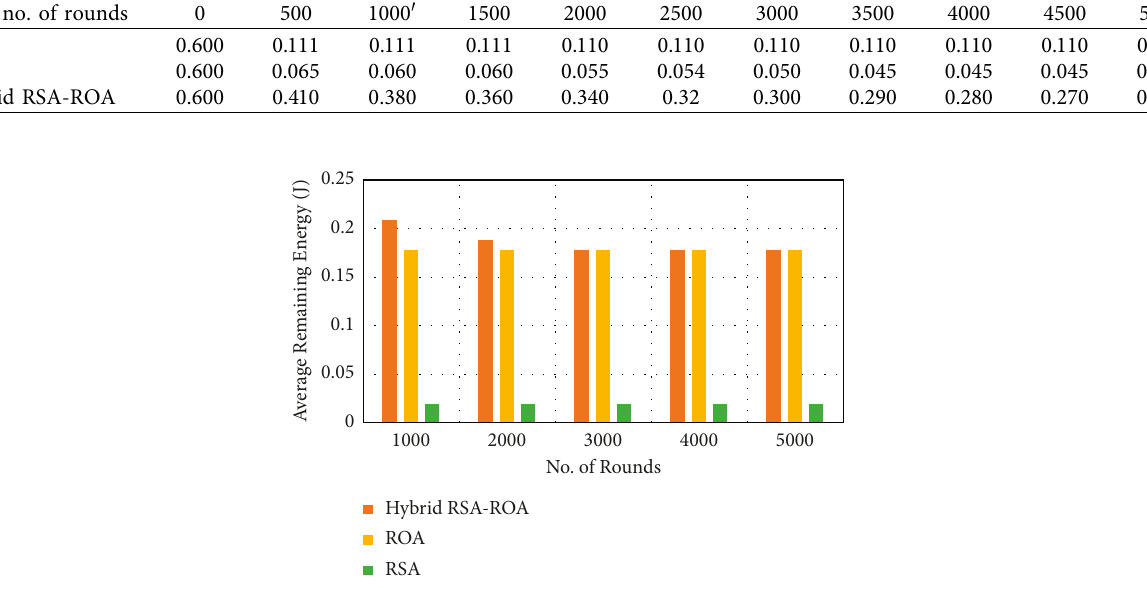
Figure 4: Graphical representation of the proposed model for remaining energy in network 2. Table 9: Average remaining energy over different number of rounds for network 2.